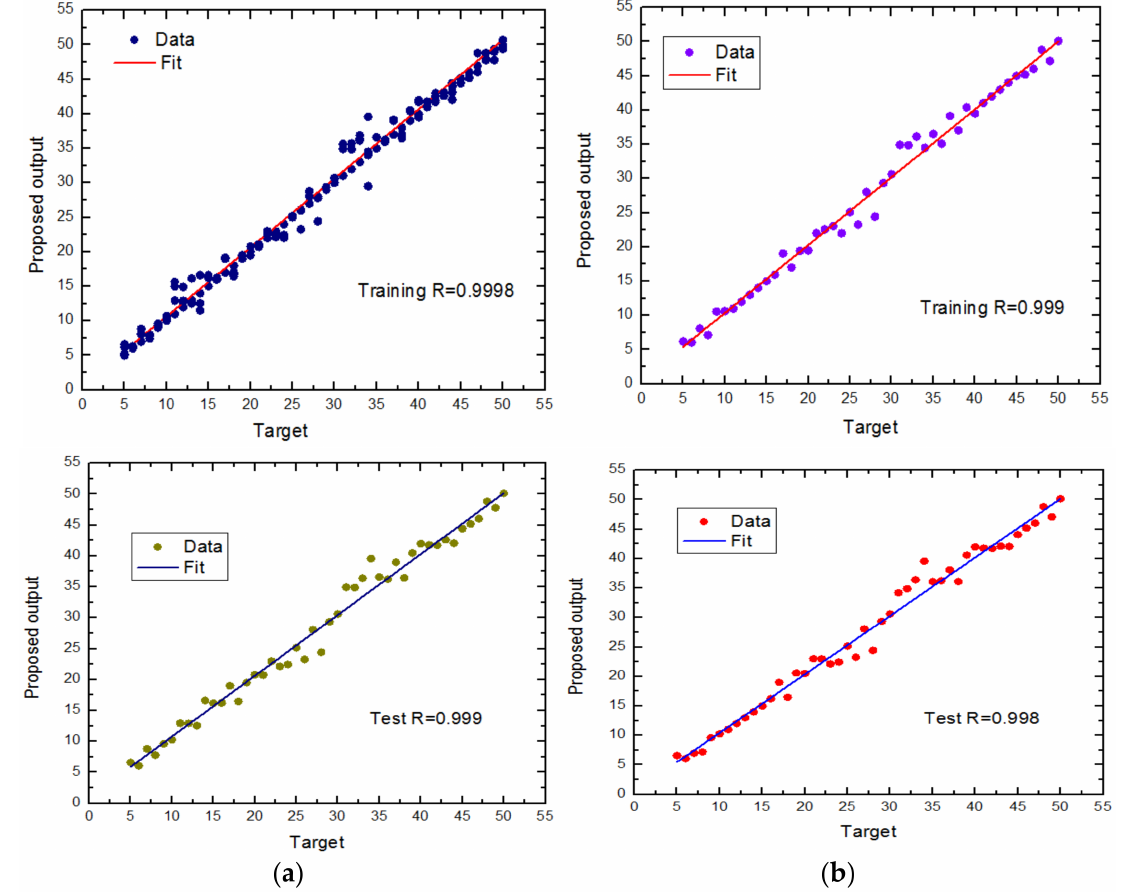
Figure 4. The training and testing phases of the proposed model’s correlation coefficient. ( a ) Heating load, ( b ) cooling load.